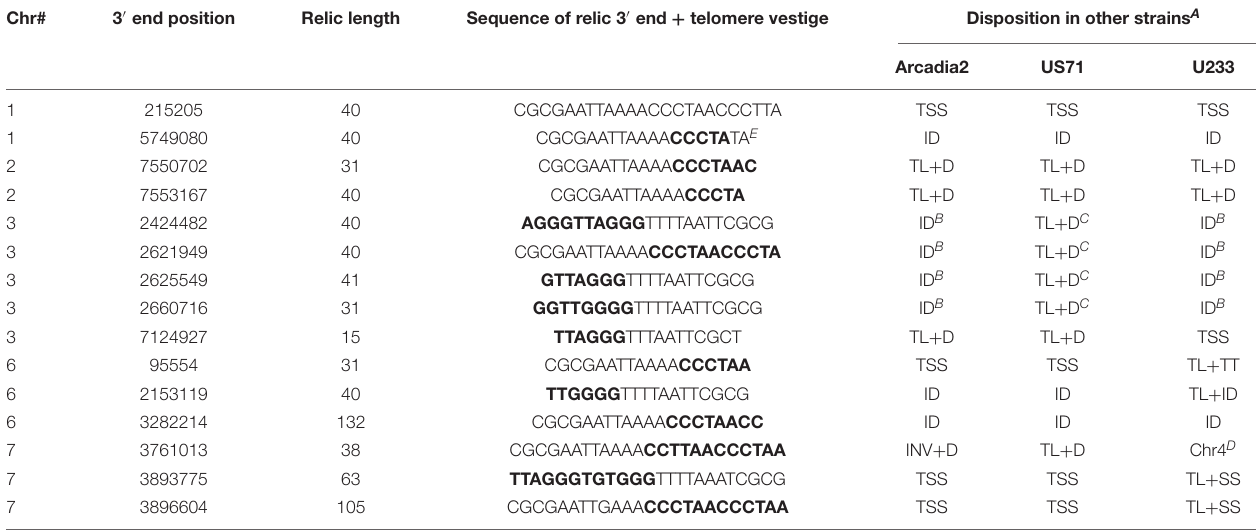
TABLE 2 | Basis for strain-to-strain polymorphism at MoTeR relic loci present in the CD156 genome. Chr# 3 (cid:48) end position Relic length